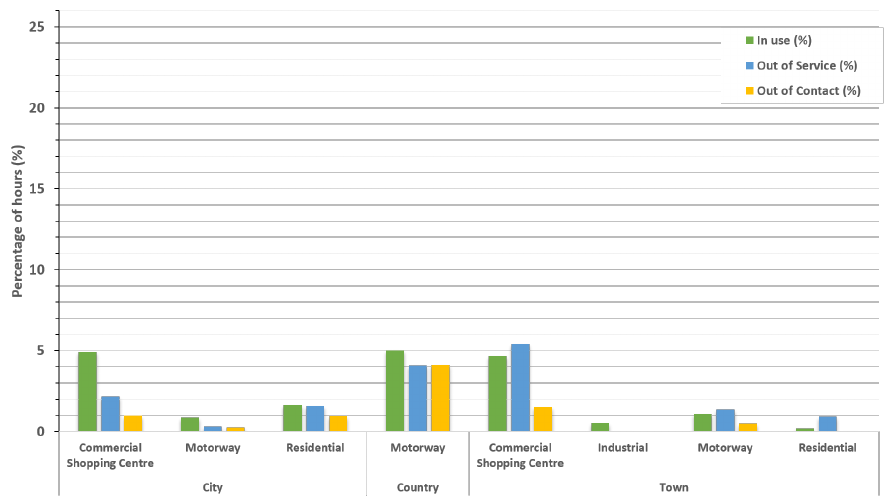
Figure 7. Total percentage of usage hours during monitored period for Standard Charging (Standard Type 2)